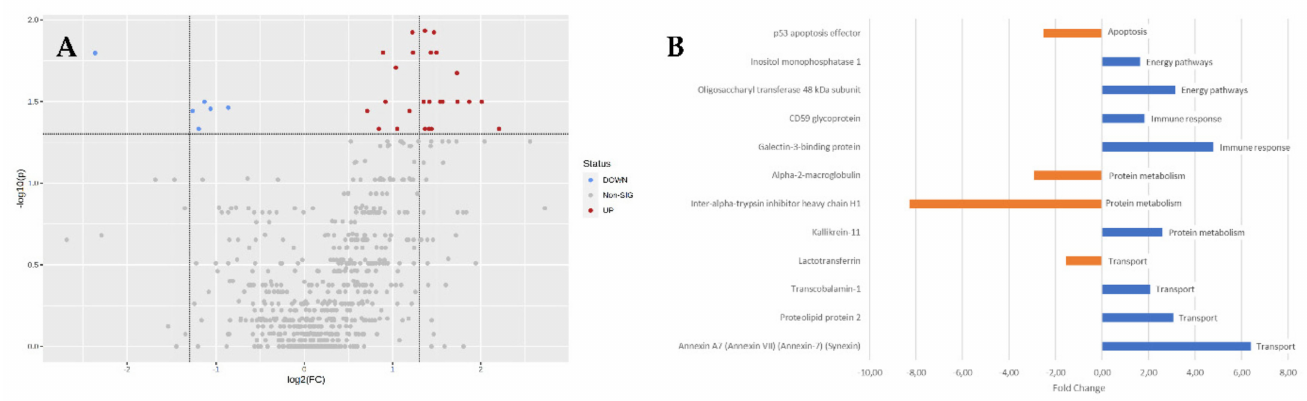
Figure 2. ( A ) Graphical representation of the protein distribution by protein expression ( X axis) and VIP score ( Y axis) variables in a Volcano plot. Blue and red dots represent up and down regulated proteins. Gray dots represent t=e proteins without regulation data. ( B ) Biological processes enrichment analysis graphical representation of the proteins with VIP score > 1 against the FunRich background database. The protein names are listed in the Y axis, with the respective fold change on the X axis. The biological process is indicated next to the graphic bar in A → Z